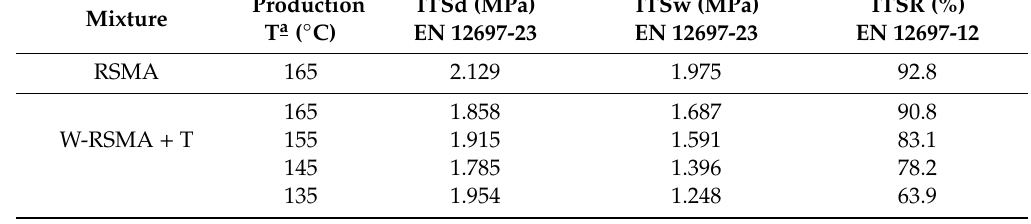
Table 6. Results of water sensitivity test for the mixtures prepared with the Marshall compactor.